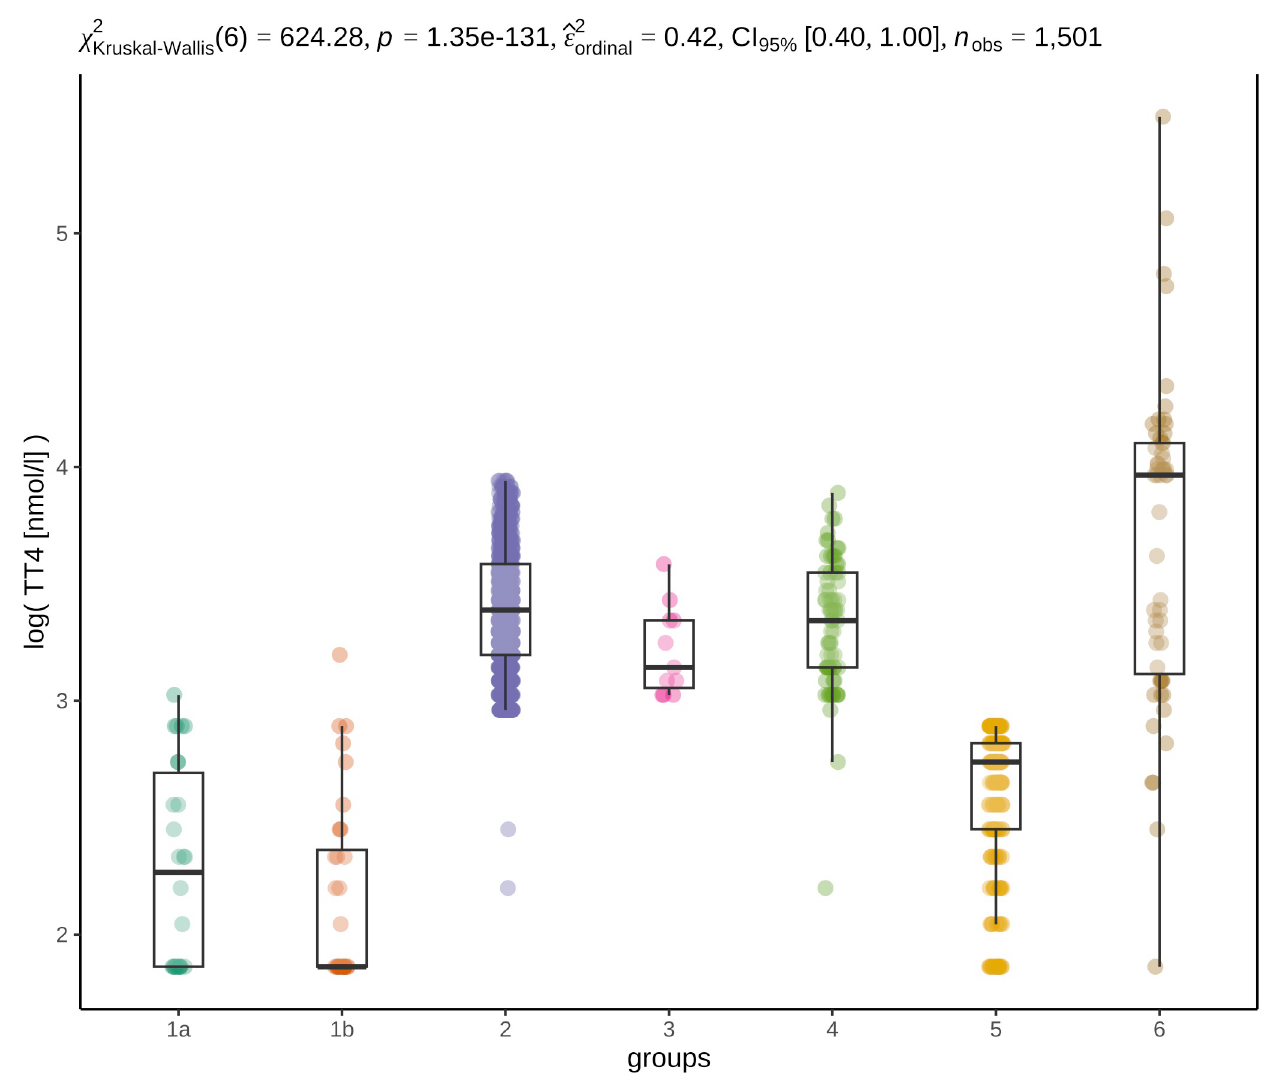
Fig 4. Box and dot plots illustrate the distribution of TT4 concentrations in the different groups. TgAA-positive hypothyroidism (group 1a), TgAA- negative hypothyroidism (group 1b), euthyroidism (group 2), subclinical hypothyroidism (group 3), TgAA-positive dogs with unremarkable thyroid function (group 4), potential nonthyroidal illness (group 5), unclassified dogs (group 6). The different groups are shown on the x-axis, and logarithmical TT4 values in the unit nmol/l are shown on the y-axis. At least one of the groups differs from the other groups, as suggested by the p value of 1.35e-131 (p < 0.001) displayed in the first line of the graphic [45]. Partial epsilon squared ( ^ ε ^2 ) with a 95% CI as the measure of the effect size for Kruskal–Wallis ordinal test is 0.42 and demonstrates that the effect of the groups on the distribution of TT4 concentrations is large [45]. Dunn pairwise test was used as a post hoc test. A significant difference was found in the distribution of TT4 concentrations in group 1a (1a/2, 1a/4, 1a/6, p < 0.001; 1a/3, p < 0.01), group 1b (1b/2, 1b/4, 1b/6, p < 0.001; 1b/3 p < 0.01) and group 5 (5/2, 5/4, 5/6, p < 0.001; 5/3, p < 0.01) compared with all the other groups, but not with each other, and group 6 was significantly different from all the other groups (6/1a, 6/1b, 6/5, p < 0.001; 6/4, p < 0.01; 6/2, 6/3, p < 0.05).